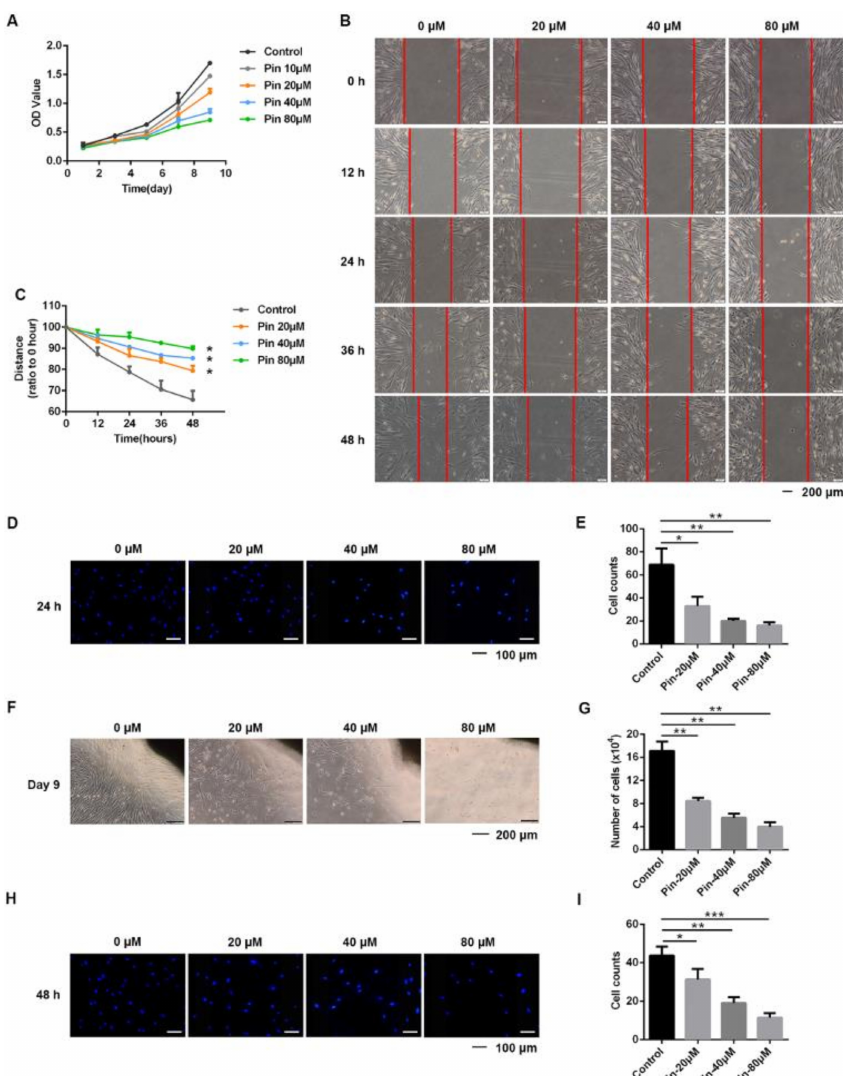
Figure 2. Pinocembrin suppresses the proliferation, migration, and invasion of keloid fibroblasts. ( A ) The CCK-8 assay of KFs. KFs were exposed to the indicated concentrations of pinocembrin (0 to 80 µ M) for 1, 3, 5, 7, and 9 days. ( B , C ) The wound healing assay was used to analyze the migration of KFs treated with pinocembrin (0, 20, 40, 80 µ M). The wound closure was photographed at 0, 12, 24, 36, and 48 h post-scratching. ( D , E ) Migratory capabilities of KFs treated with various concentrations of pinocembrin were investigated by transwell assays. Images were captured and counted under a fluorescence microscope at × 200 (scale bar = 100 µ m). ( F , G ) Representative images of tissue explants cultured with pinocembrin at day 9 ( × 40, scale bar = 200 µ m). The cell numbers that migrated out of the tissue explants were quantified at day 9. ( H , I ) Invasive capabilities of KFs treated with various concentrations of pinocembrin were investigated by transwell assays. Images were captured and counted under a fluorescence microscope at × 200 (scale bar = 100 µ m). Data were presented as the means ± SD, n = 3. * p < 0.05; ** p < 0.01; *** p <